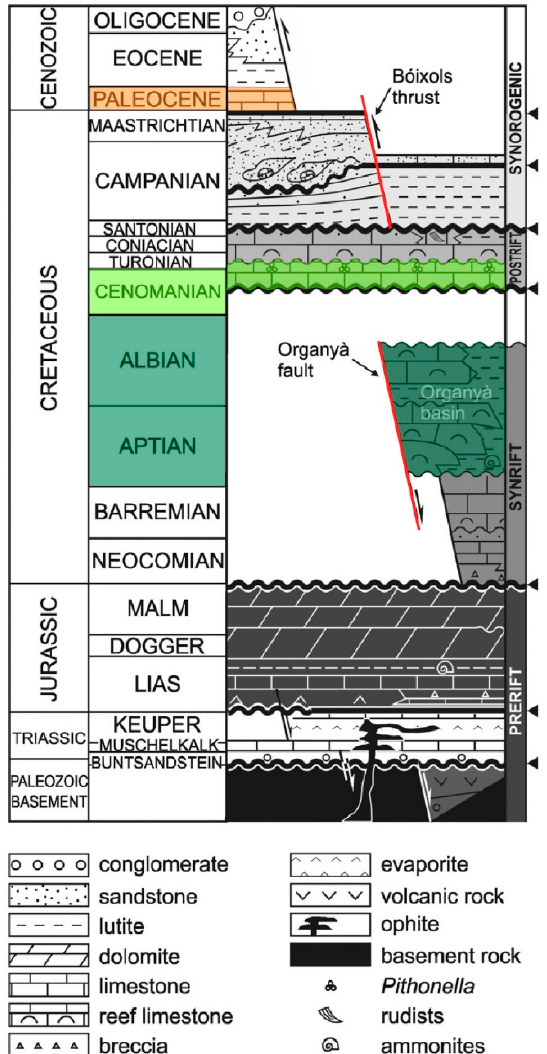
Figure 2. Chronostratigraphic diagram showing the principal stratigraphic units and their related tectonic events [72]. The outcropping units, where all the samples were taken from, are colored in orange (Garumnian facies), light green (Santa Fe Fm.) and dark green (Lluçà Fm.).